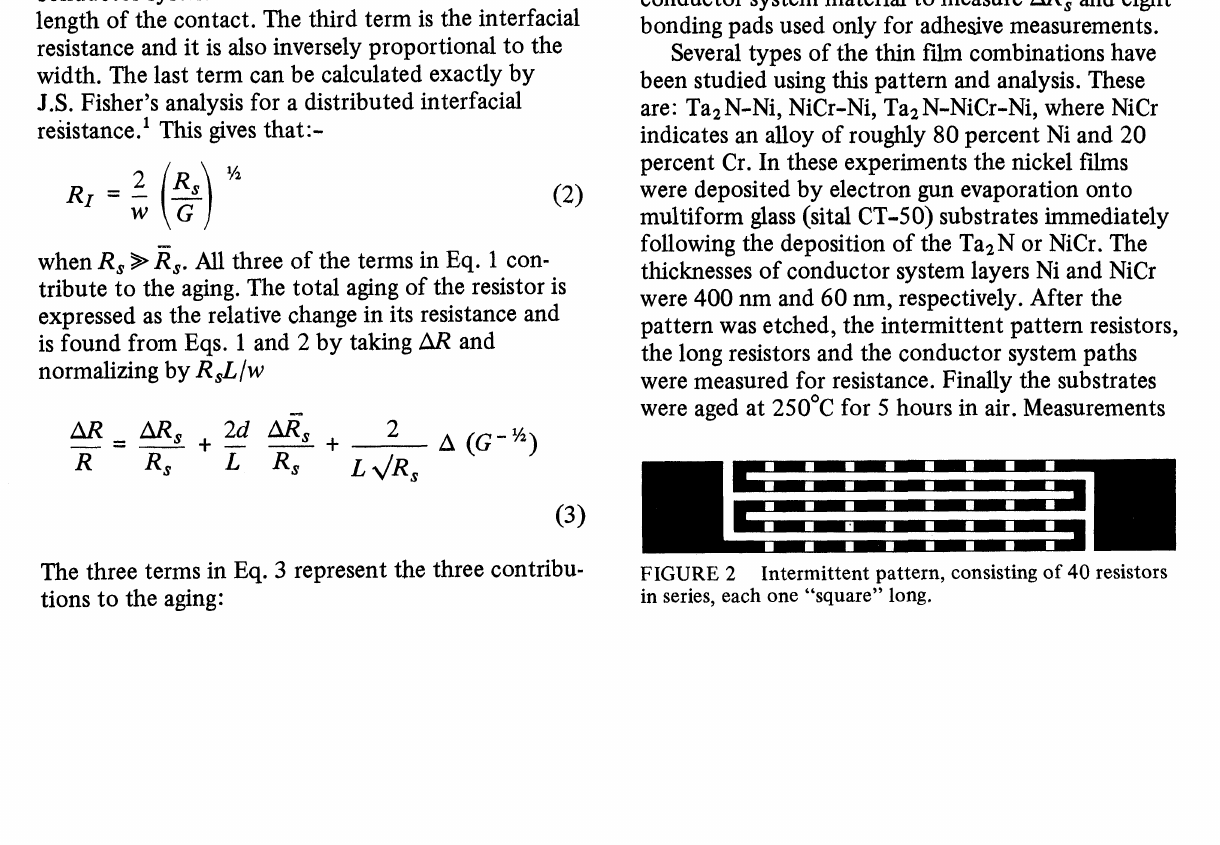
Intermittent pattern, consisting of 40 resistors in series, each one "square"